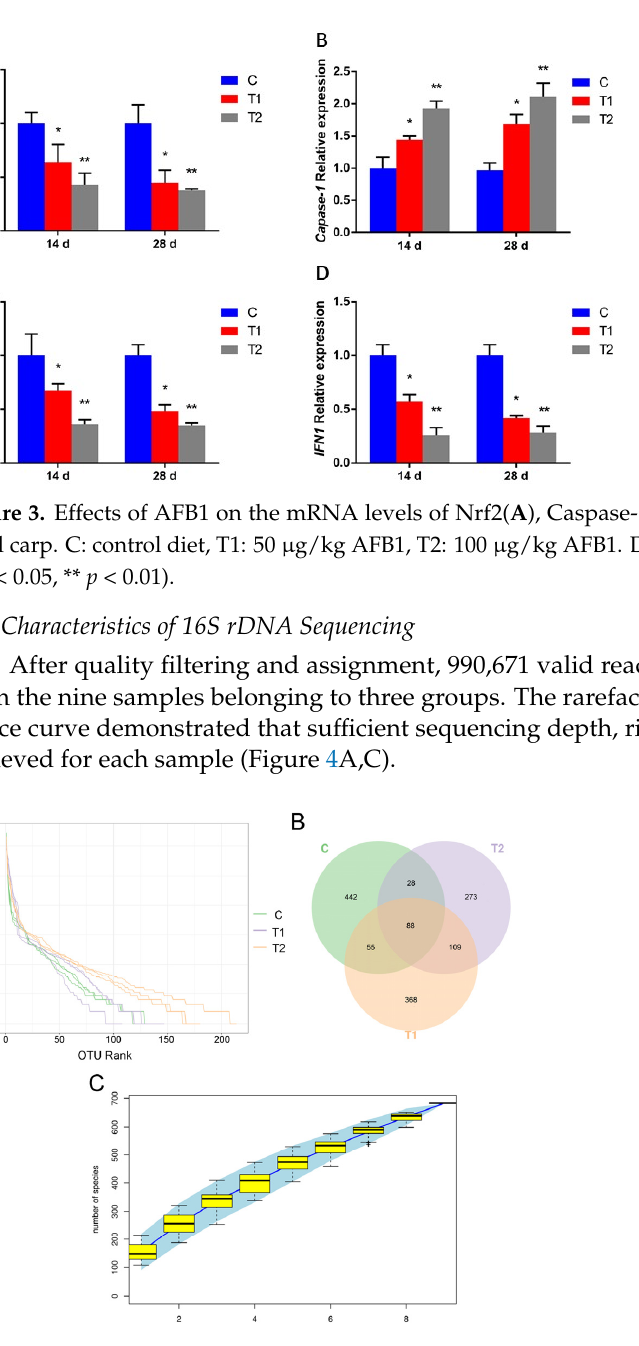
Figure 4. Rarefaction curves, Venn diagram, and rank abundance curve of different treatment groups of gibel carp exposed to aflatoxin B1 for 28 days. ( A ) Rarefaction curves. ( B ) Venn diagram representing the operational taxonomic units (OTUs) shared among treatment groups. ( C ) Rank abundance curve. C: control diet, T1: 50 µg/kg AFB1, T2: 100 µg/kg AFB1.